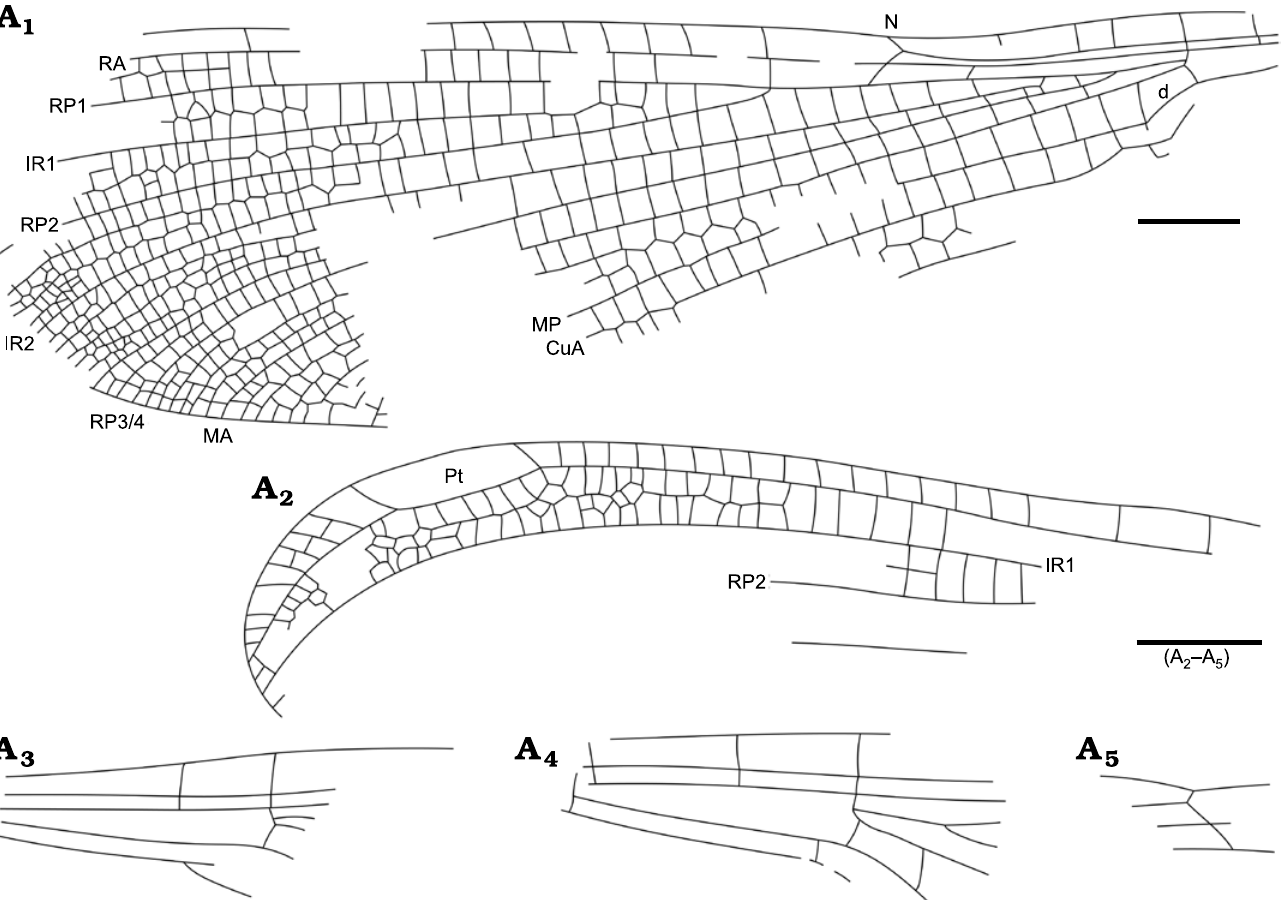
Fig. 5. Reconstructions of wing of zygopteran odonatan Menatagrion hervetae gen. et sp. nov., holotype MNT Nel Odo 1; from Paleocene, Menat, France. Wing (A 1 ), apex (A 2 ), base (A 3 ), base (A 4 ), and nodus (A 5 ) region. Scale bars 2